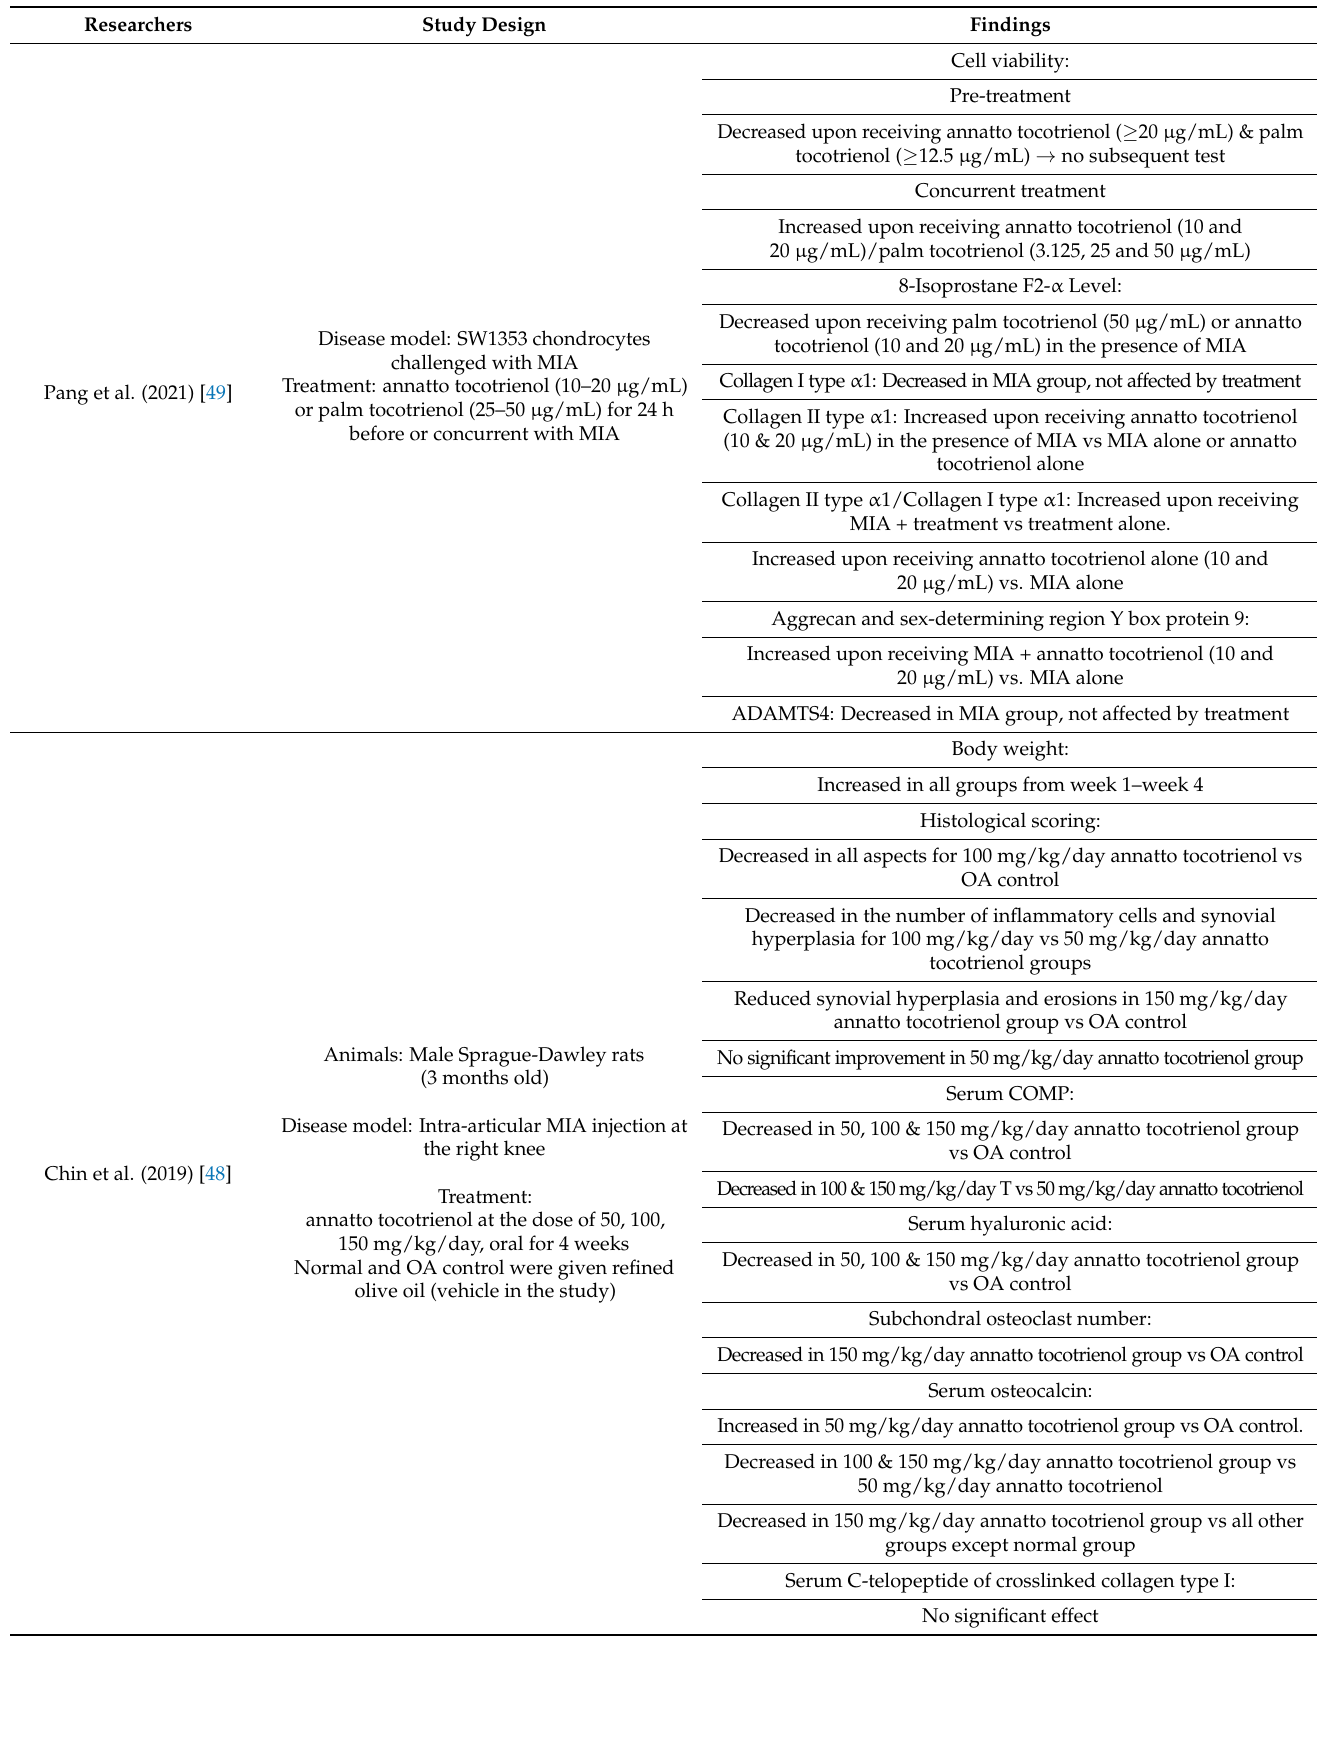
Table 1. The effects of tocotrienol on